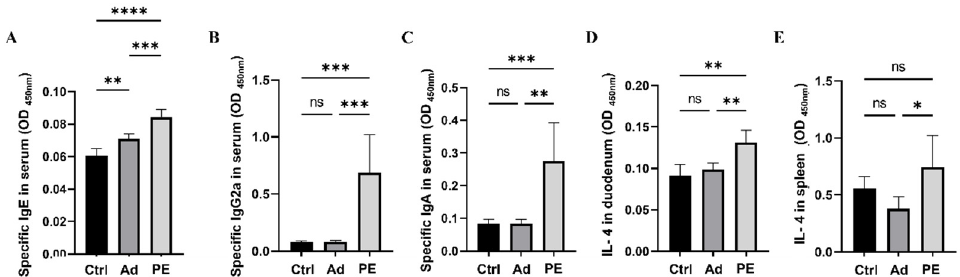
Figure 3. The levels of peanut-specific antibodies in serum and IL-4 in duodenum and spleen in mice ( n = 6/group for peanut-specific antibodies, n = 5/group for IL-4 in duodenum and spleen). ( A ) The level of sIgE in serum. ( B ) The level of sIgG2a in serum. ( C ) The level of sIgA in serum. ( D ) The level of IL-4 in duodenum. ( E ) The level of IL-4 in spleen. ns: no significance; *: p < 0.05; **: p < 0.01; ***: p < 0.001; ****: p < 0.0001.